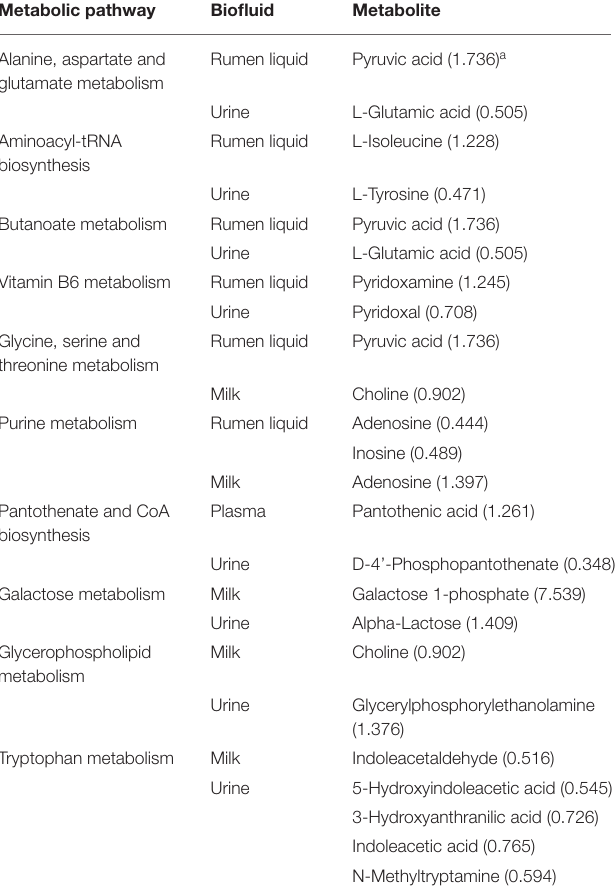
TABLE 4 | Common differential metabolic pathways identified from the significantly different metabolites across different biofluids between the SBM group and FSBM